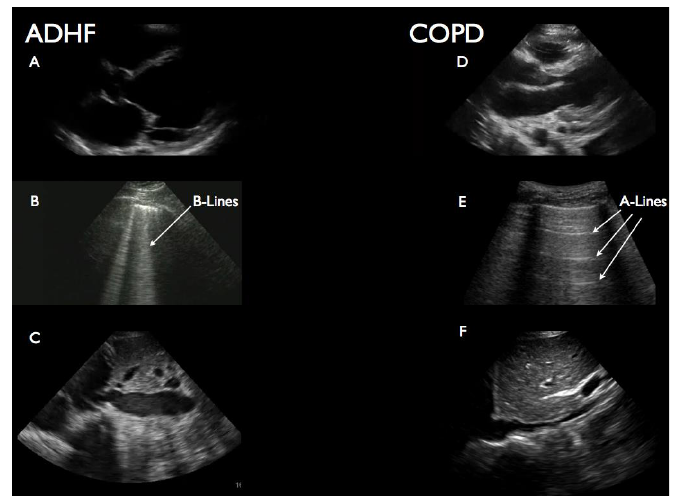
Figure 1. Typical findings on “triple scan” (TS) in acute decompensated heart failure (ADHF) and chronic obstructive pulmonary disease (COPD)/asthma. Images a-c show typical findings of ADHF: dilated left ventricle with poor mitral valve opening (a); vertical b-line artifacts in this case indicating excess lung water (b); dilated inferior vena cava (IVC [lacking respiratory variation]) (c). Images d-e show typical findings in COPD/asthma: normal left ventricle (often hyperdynamic) (d), horizontal a-line artifacts indicating hyperinflation (e) and normal IVC